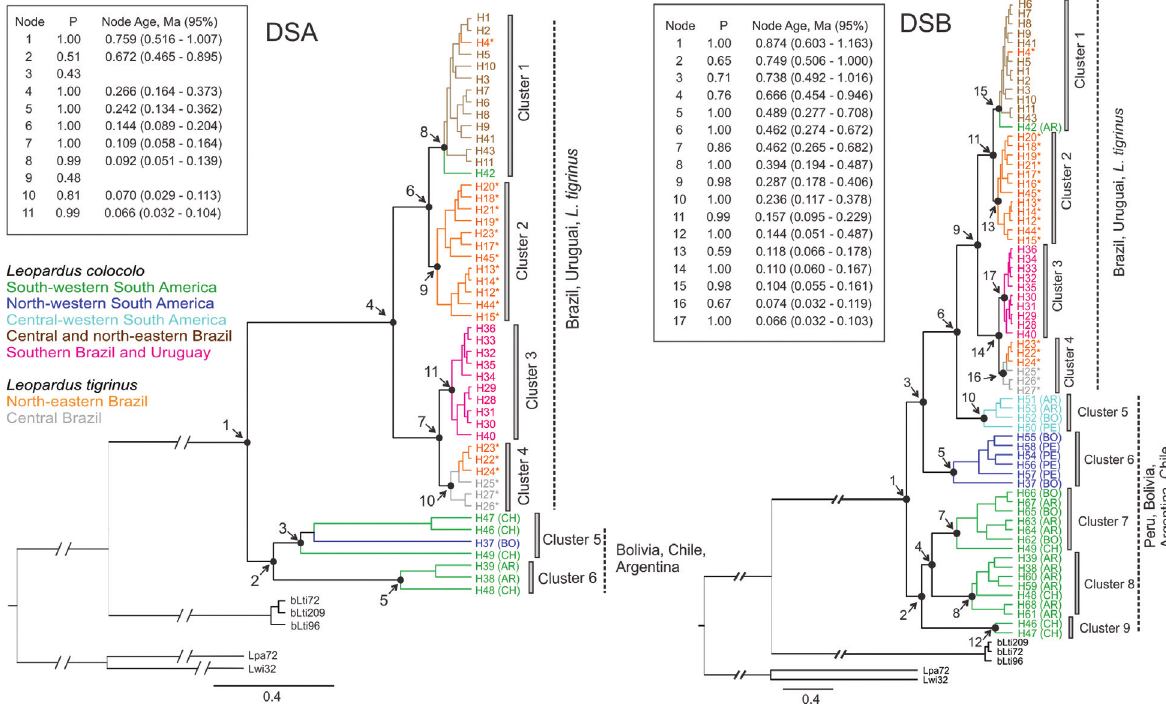
Figure 2 - Phylogenetic relationships among Leopardus colocola and L. tigrinus mitochondrial haplotypes, as assessed with dataset A (DSA) and dataset B (DSB), and depicted in Bayesian trees generated with BEAST. Insets depict each of the main nodes, with posterior probability (P) and node age in mil- lionyearsago,withrespective95%credibilityintervals.Thefivecolorsassociatedto L.colocola haplotypesarethesameusedinFigure4tohighlightthe five genetic groups identified in this species. The grey and orange colors indicate the haplotypes found only in L. tigrinus